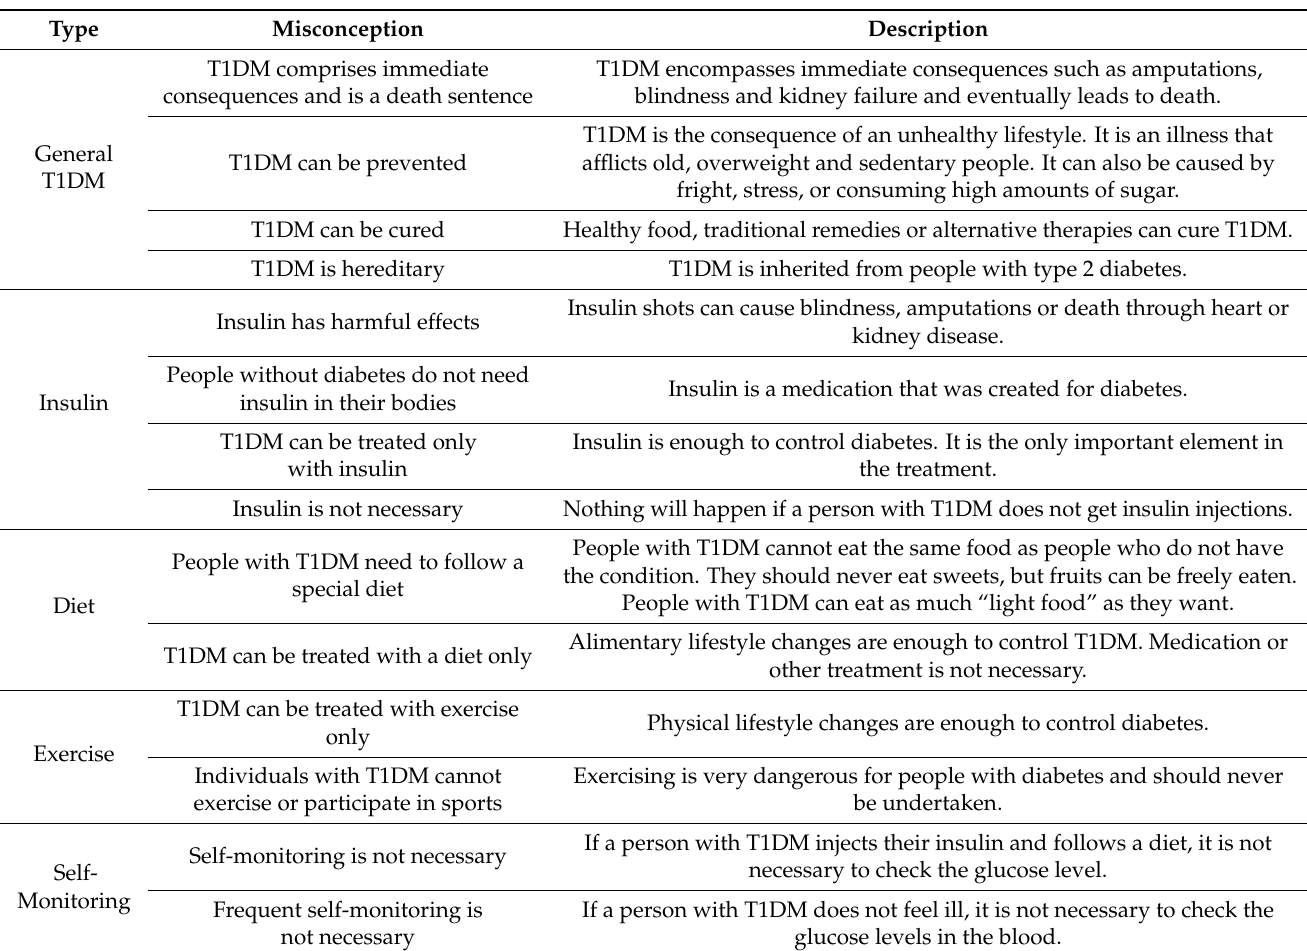
scribed in Table 1: (1) general fallacies about T1DM, (2) insulin, (3) diet, (4) exercise and (5) self-monitoring. Table 1. Frequent Type 1 Diabetes (T1DM) misconceptions in